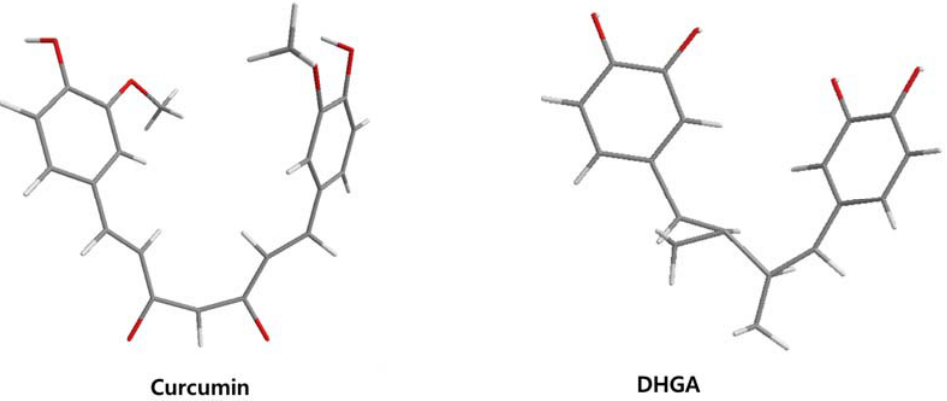
Figure 1. The lowest energy conformation of curcumin and DHGA.